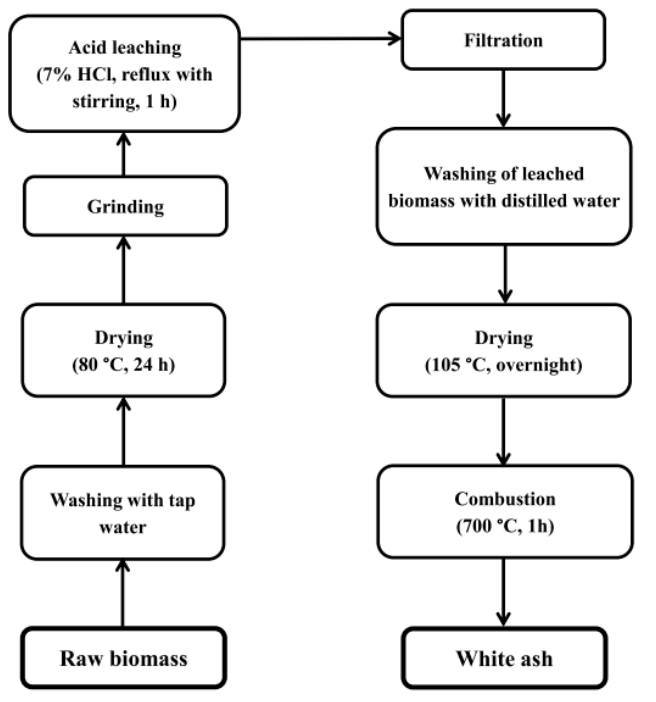
Figure 1. Scheme of the two-step process for the preparation of silica powders from various types of biomass. of